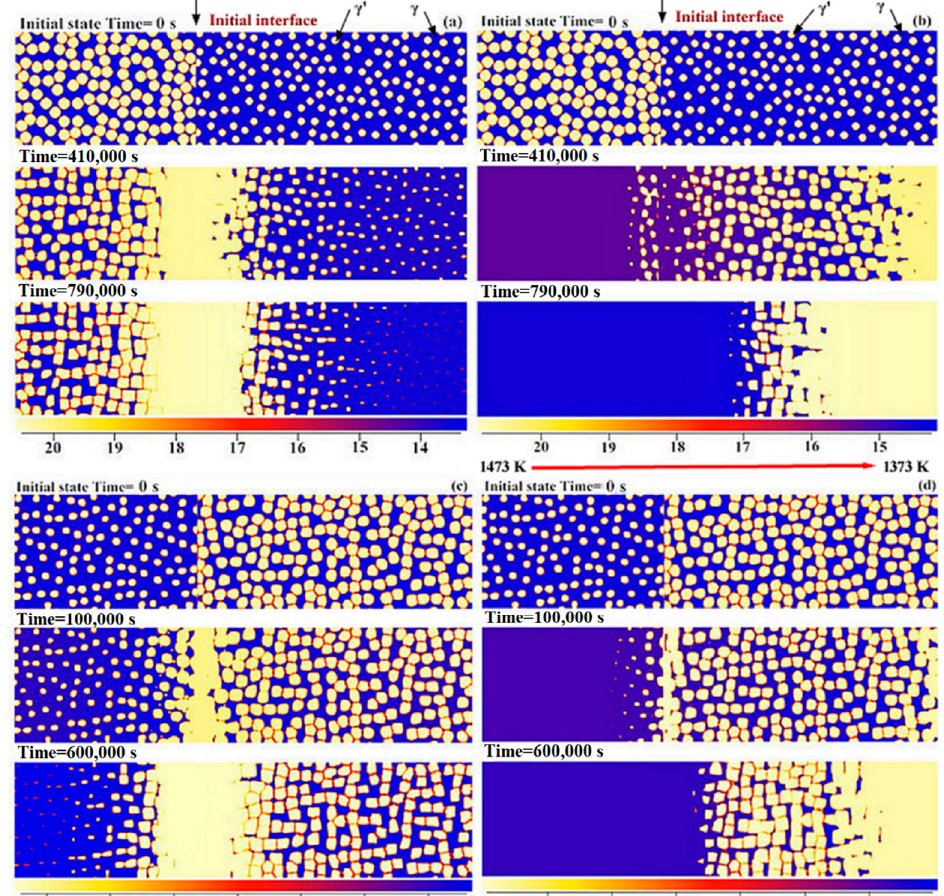
Figure 9. Phase-field simulated microstructure evolution of No. 7 γ + γ '/ γ + γ ' bond coat/substrate